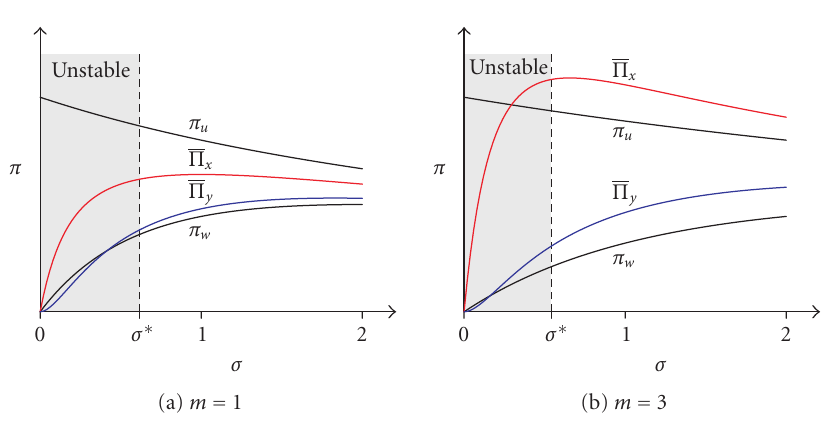
Figure 3.1. Critical π